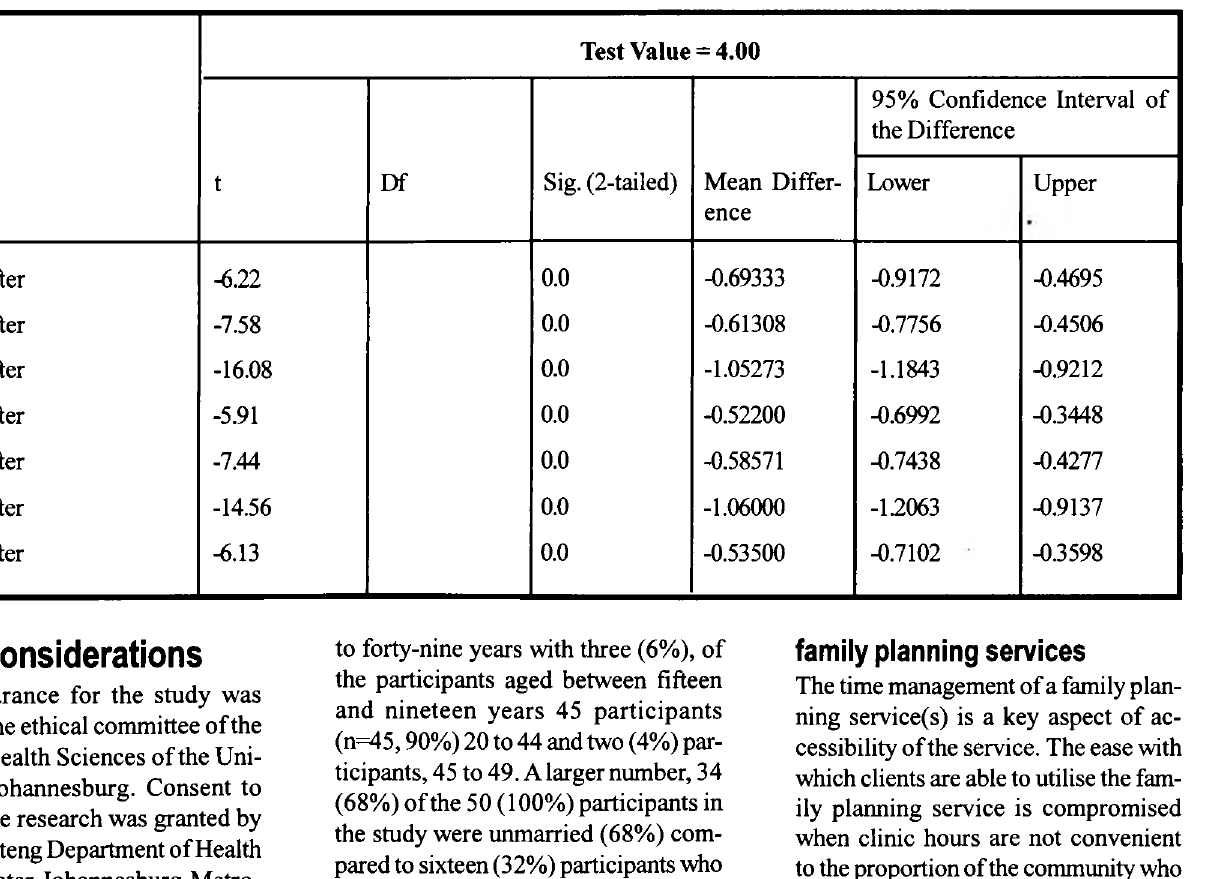
t Df Sig. (2-tailed) Mean Differ­